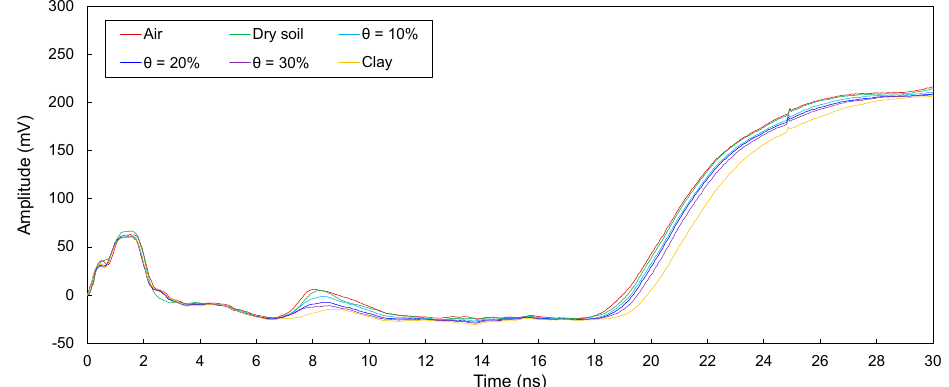
Figure 9. Measured signals for D2 with the defect filled with different materials of air; dry sand; wet sands with θ = 10%, 20%, and 30%; and clay.